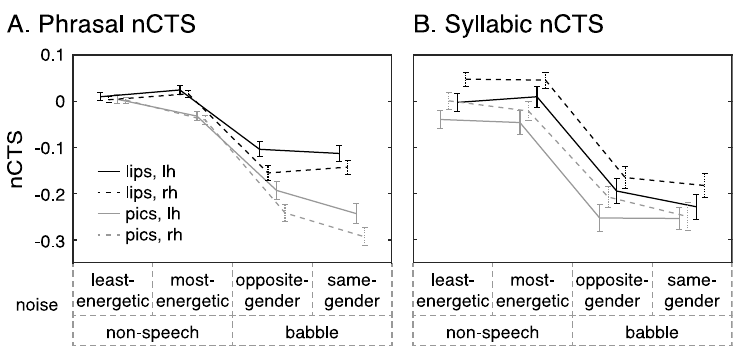
Fig 2. Impact of the main fixed effects on the nCTS at phrasal (A) and syllabic rates (B). Mean and SEM values are displayed as a function of noise properties. The four traces correspond to visual conditions with the speaker’s talking face visible (lips; black traces) and with static pictures illustrating the story (pics; gray traces), within the left (lh; connected traces) and right (rh; dashed traces) hemispheres. nCTS values are bounded between − 1 and 1, with values below 0 indicating lower CTS in speech-in-noise conditions than in noiseless conditions. S2 Data contains the underlying data for this figure. lh, left hemisphere; nCTS, normalized cortical tracking of speech; rh, right hemisphere.